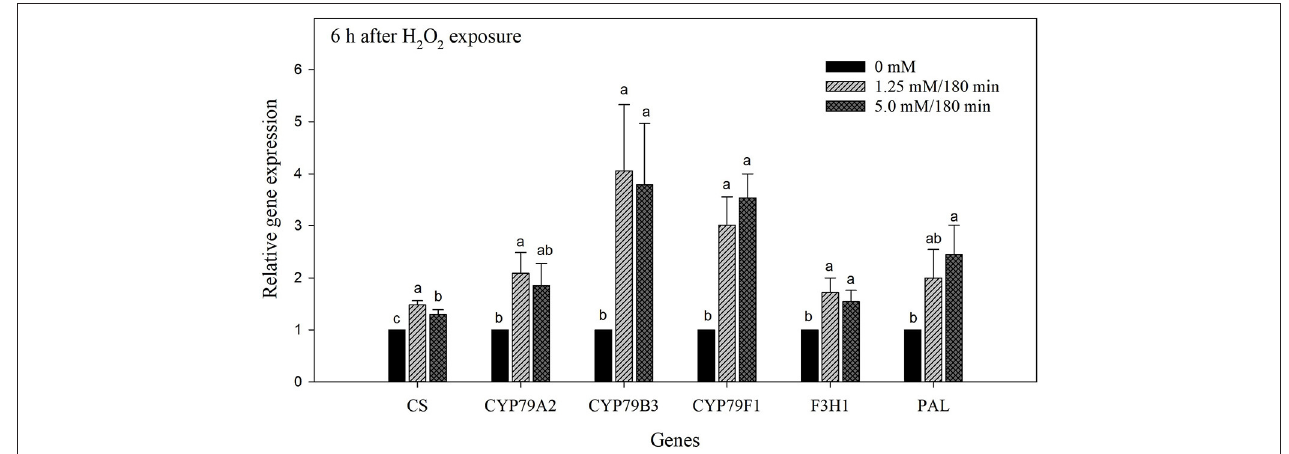
FIGURE 7 | Gene expression analysis of broccoli florets exposed to H 2 O 2 on day 0. Florets were treated with H 2 O 2 at 0; 1.25 mM/180min (hormetic dose); and 5 mM/180min (high dose) stored at 4 ◦ C/90–95% RH and the values were normalized against actin. Gene expression in broccoli florets exposed to H 2 O 2 was measured after each treatment on chalcone synthase (CHS); phenylalanine N-hydroxylase (CYP79A2); tryptophan N-hydroxylase 2 (CYP79B3); dihomomethionine N-hydroxylase (CYP79F1); flavanone 3-hydroxylase (F3H1); and phenylalanine ammonia-lyase (PAL). Values were averaged and the standard deviation is presented with vertical bars, representing 3 replicates per treatment ( n 3). Comparisons for all pairs using Tukey-Kramer HSD are shown with different letters. =